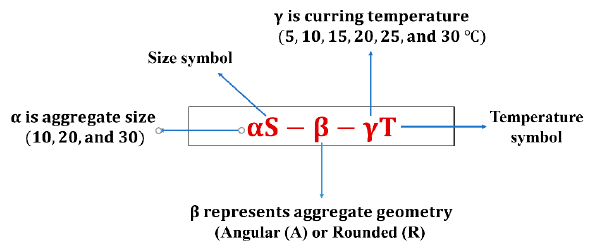
Figure 3. Codding details used to name laboratory specimens.